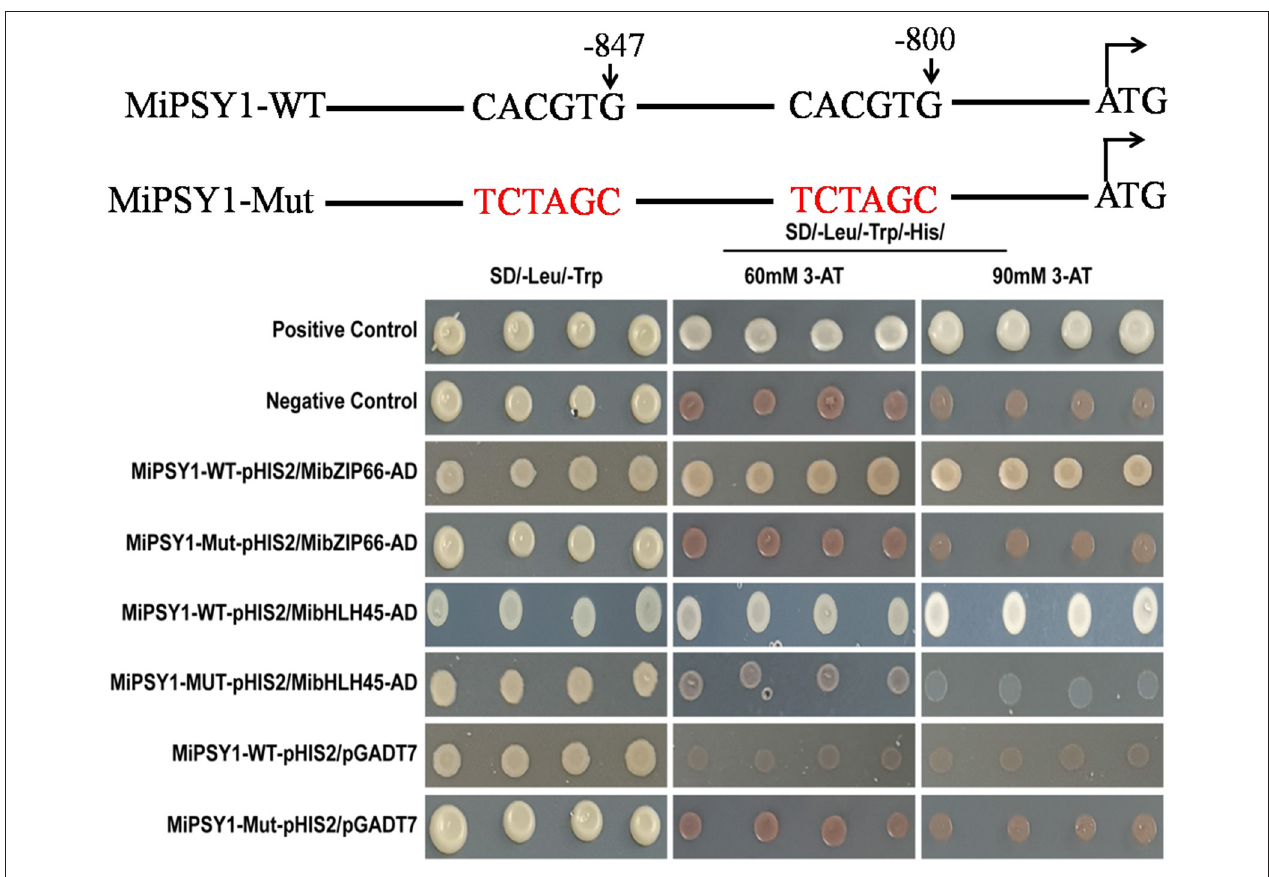
FIGURE 8 | Yeast one-hybrid assay of MibZIP66 and MibHLH45 binding to the actual (WT) and mutated (Mut) promoters of